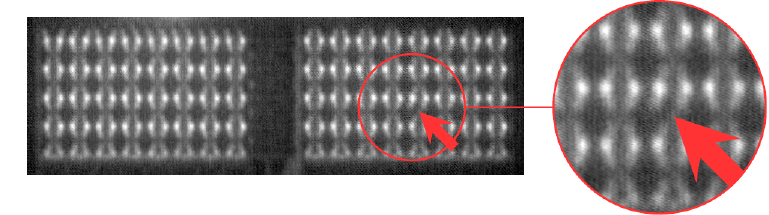
Figure 11: Data dependency of the TLS response. A single bit (bit 120) has been set in the BBRAM key data which manifests as an irregularity in the measurement result.